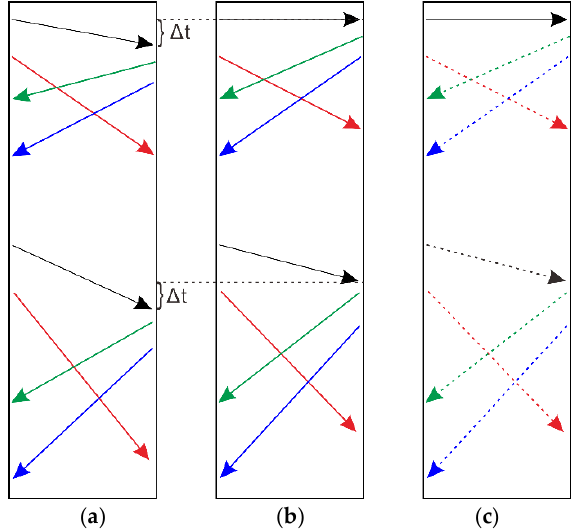
Figure 1. The process of separating a single wavefield using the conventional median filter in the case of non-parallel events in the target wavefield. Δ t represents the masximum time shift of the first arrival; black arrows denote downgoing P-wave events, red arrows denote downgoing S-wave events, green arrows denote upgoing S-wave events, and blue arrows denote upgoing S-wave events. ( a ) Original seismic data; ( b ) Statically aligned data; ( c ) Target wavefield after median filtering.